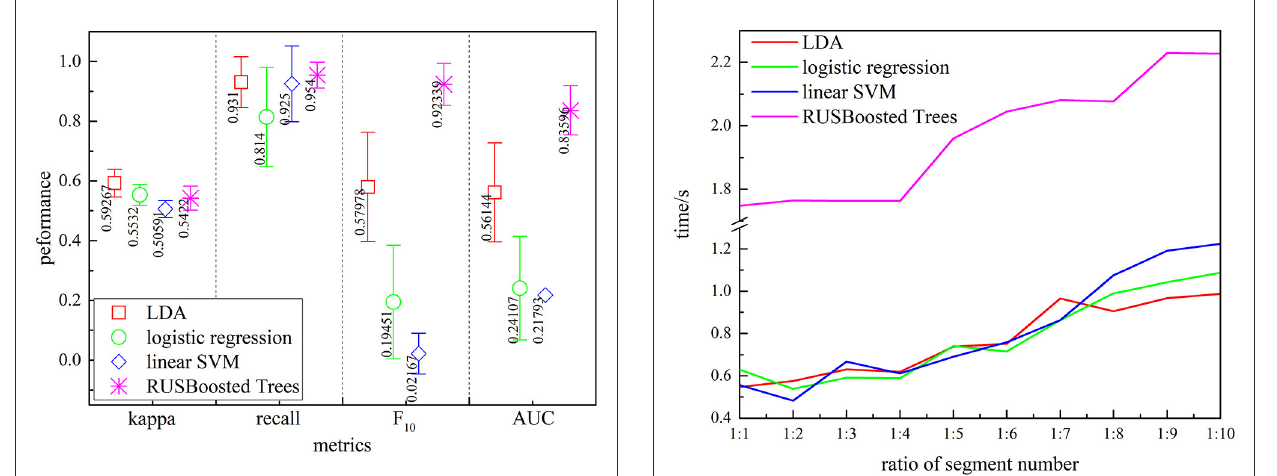
FIGURE12 Performance comparison of the proposed method with different machine learning algorithms for the detection of k-complexes [LDA (red diamond), logistic regression (green circle), linear SVM (blue diamond), and RUSBoosted tree (pink star)]. Error bars correspond to the standard error of the mean.